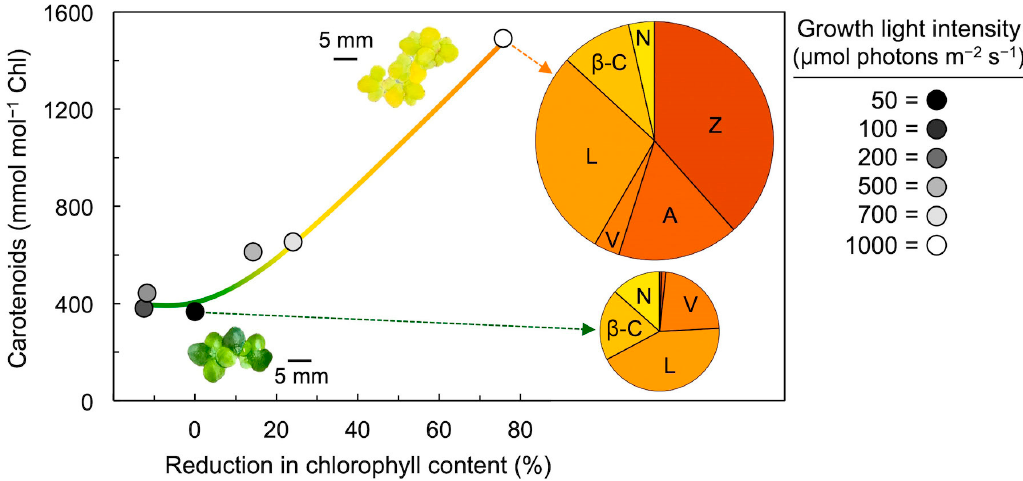
Figure 3. Level of carotenoids (relative to chlorophyll) as a function of reduction in chlorophyll content in fronds of duckweed ( Lemna gibba ) that had developed under continuous light ranging across six growth light intensities from 50 to 1000 µmol photons m − 2 s − 1 (i.e., from 4.32 to 86.4 mol photons per square meter per 24-h period). Reduction in chlorophyll content is expressed as percent reduction relative to the chlorophyll level in fronds grown under the lowest light intensity of 50 µmol photons m − 2 s − 1 . Images of duckweed colonies that developed under 50 and 1000 µmol photons m − 2 s − 1 are also shown, as well as pie diagrams depicting the relative levels of each of the six carotenoids present in those fronds (where total pie area represents carotenoid content per chlorophyll). Chl = chlorophyll, V = violaxanthin, A = antheraxanthin, Z = zeaxanthin, L = lutein, β -C = β -carotene, and N = neoxanthin. Data for fronds grown under 100, 200, 500, and 700 µmol photons m − 2 s − 1 are derived from Stewart et al. [31]. Data for fronds grown under 50 and 1000 µmol photons m − 2 s − 1 are from Stewart et al. [32].